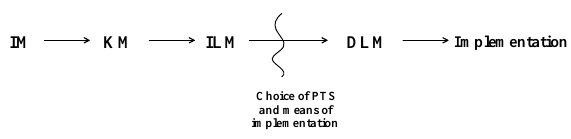
Fig. 1. Methodology of automation of intellectual work, where IM is the initial model, CM - conceptual model, ILM - infological model, DLM - datalogical model, PTS - software and hardware